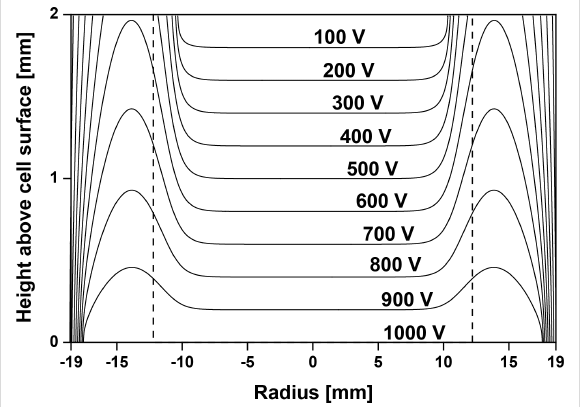
Figure 3: Electrostatic potential within the exposure chambers. Assuming a flat equipotential surface the electrostatic potential was 1 kV at the cell level. The dashed lines indicate the borders of the Transwell membrane. The field profile was simulated with SimIon (SIS, v8). Isolating parts of the Transwell insert and chamber were